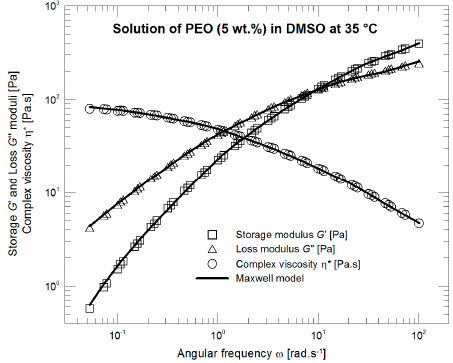
Figure 1. Master curve fitted with the Maxwell model.